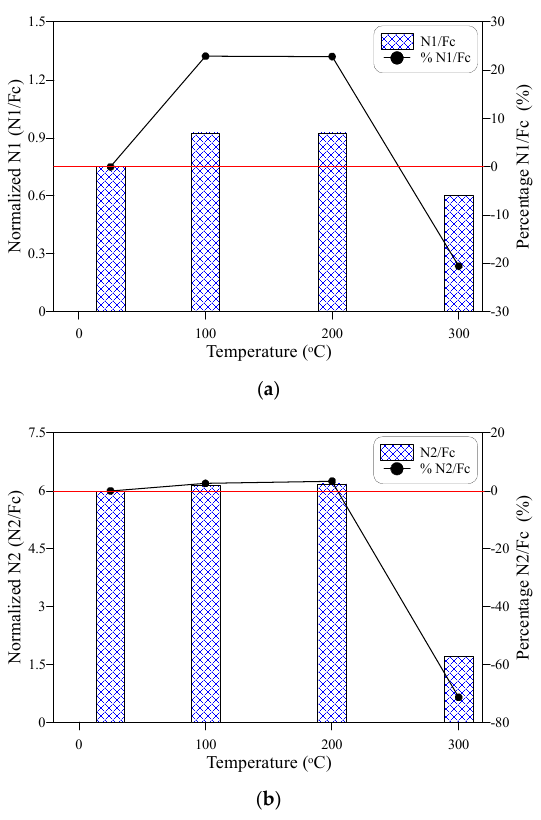
Figure 10. The behavior of normalized impact number with temperature increase ( a ) cracking num- ber N1, ( b ) failure number N2. N1, ( b ) failure number